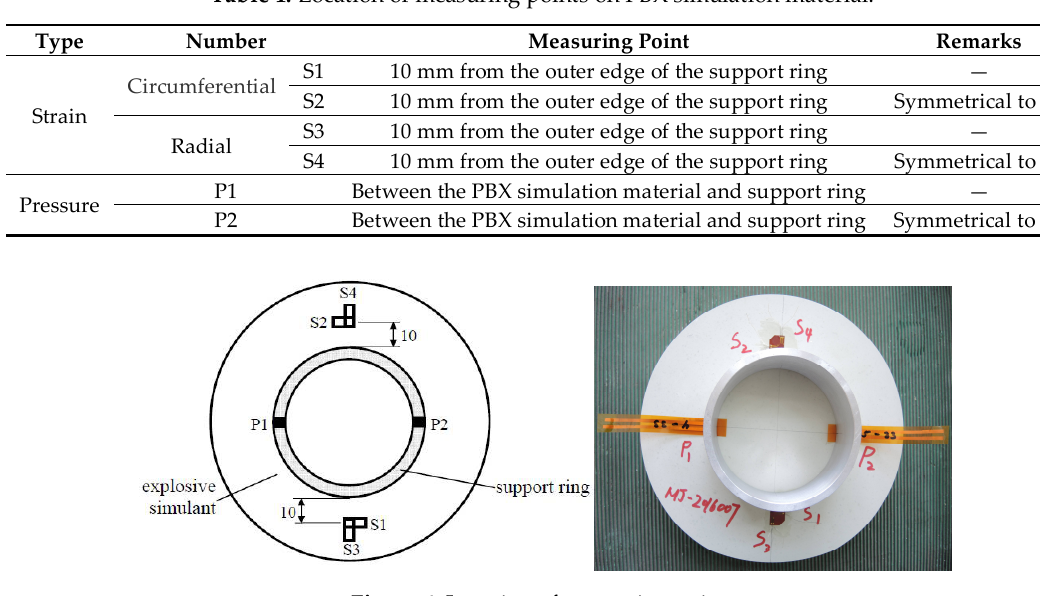
Table 1. Location of measuring points on PBX simulation material.